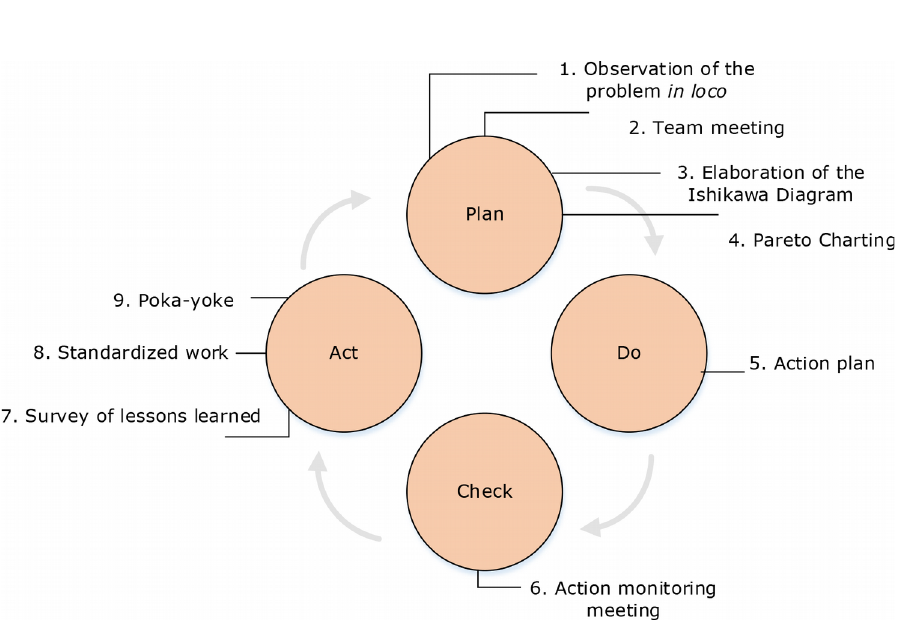
Figure 5. PDCA project management model